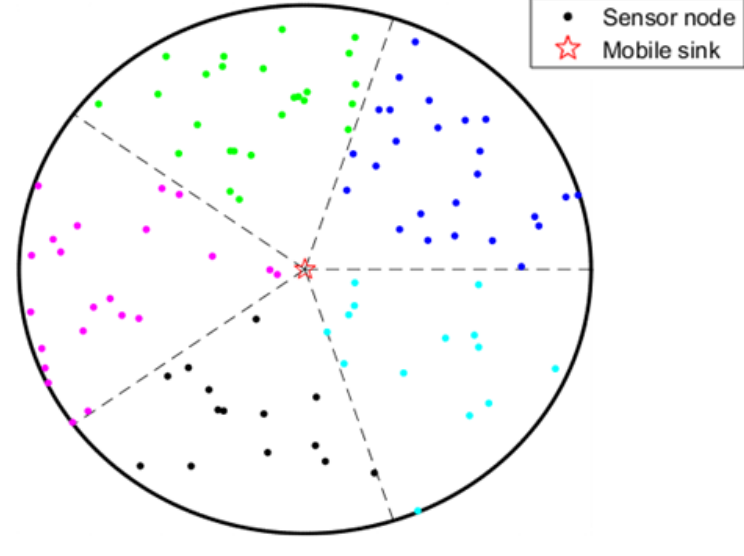
Figure 3. Clustering formation.